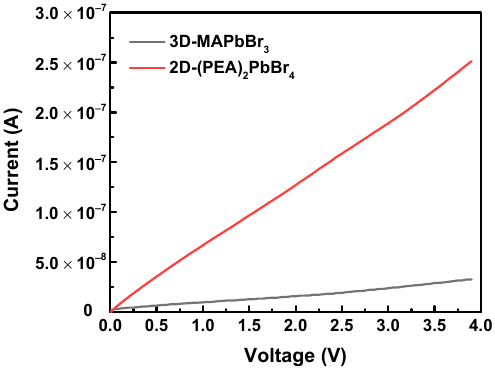
Figure 3. Current–voltage (I–V) curves of 3D-6500rpm-MAPbBr 3 and 2D-6500rpm-(PEA) 2 PbBr 4 perovskites after exposure to 95% (v/v) ethanol vapor.